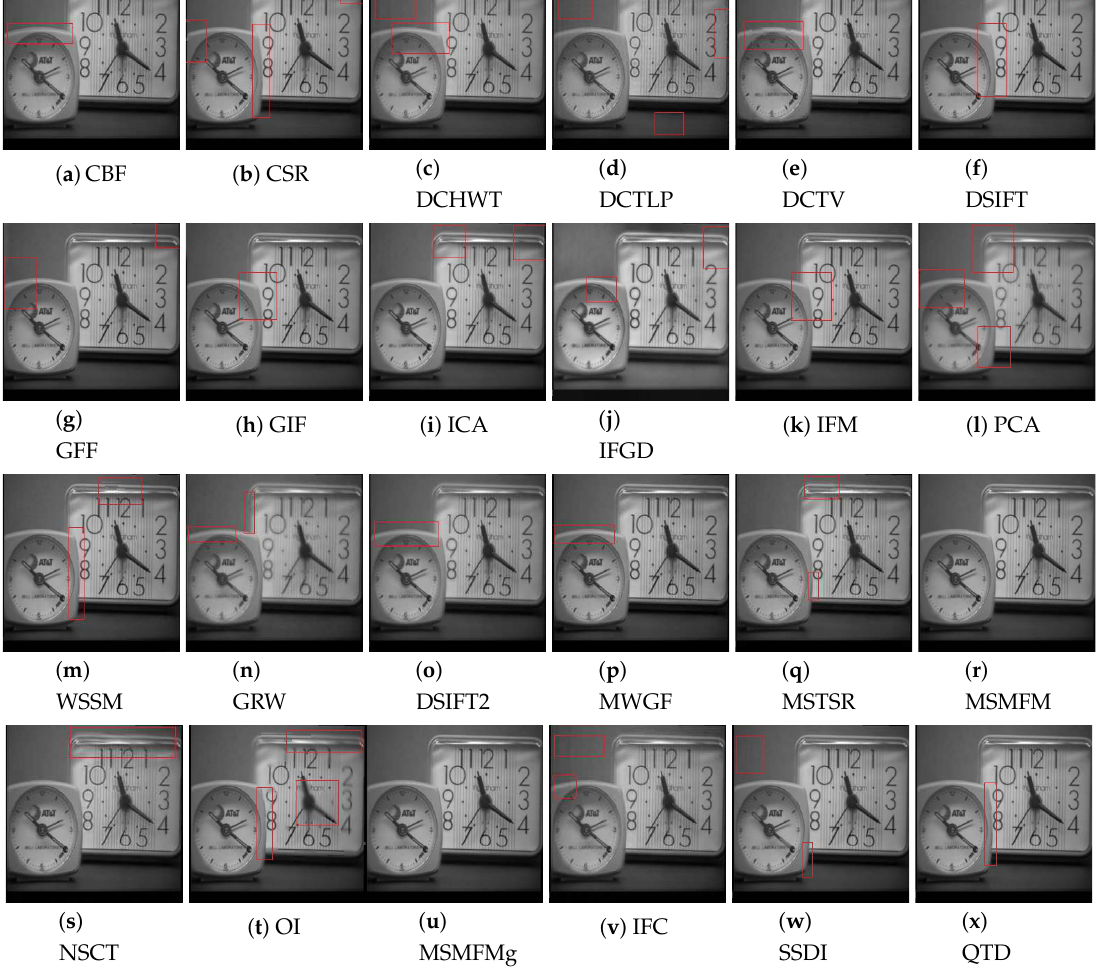
Figure 6. Visual comparison compared multi-focus image fusion methods on clock image set of the Grayscale